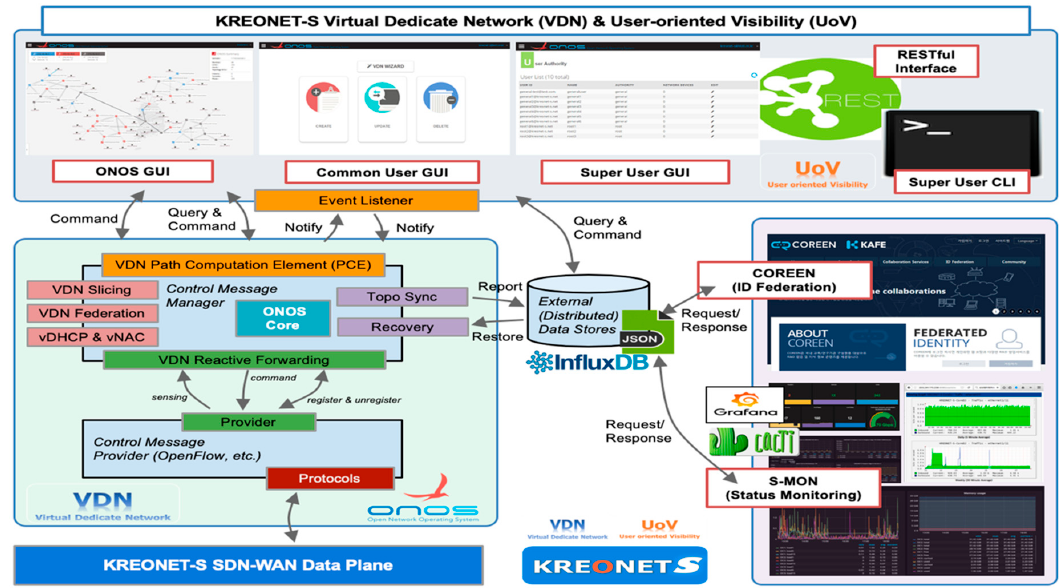
Figure 5. VDN framework: core engines, subsystems, datastore, and external systems.